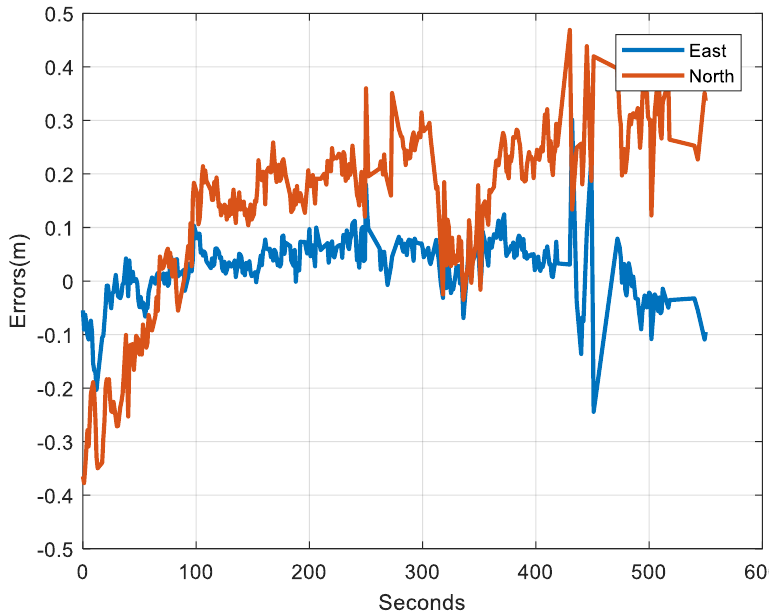
Figure 3. Horizontal errors of single-frequency precise point positioning (PPP).